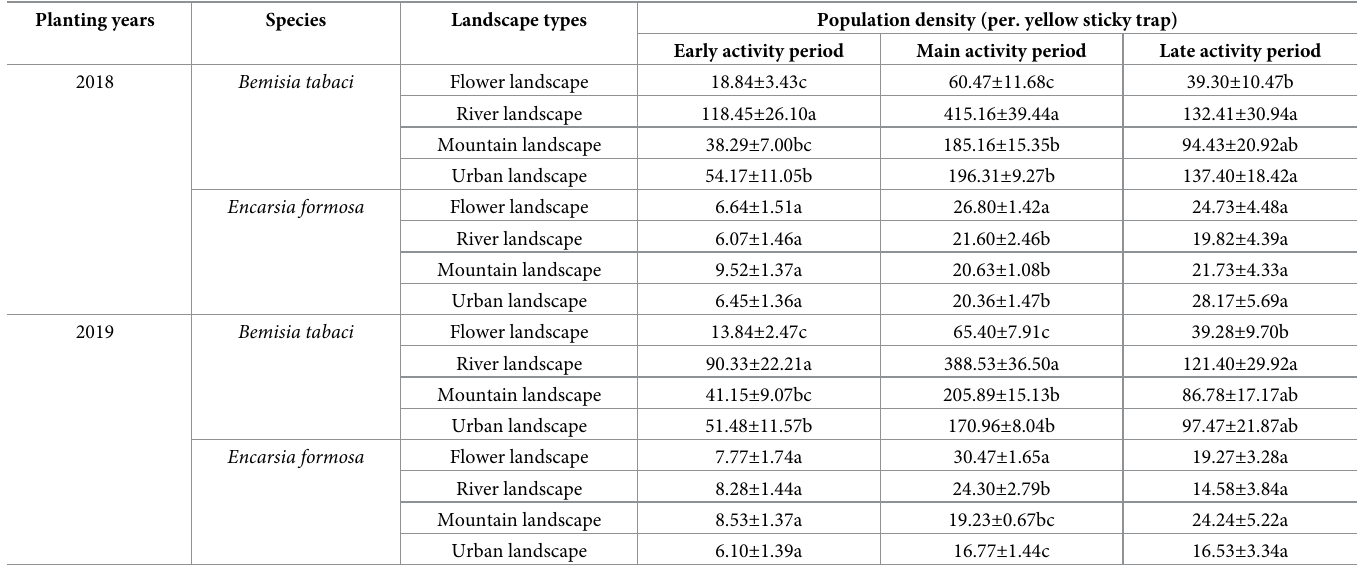
Table 4. Population density comparison of Bemisia tabaci and Encarsia formosa in different types of landscapes in Kunming, south China. Planting years